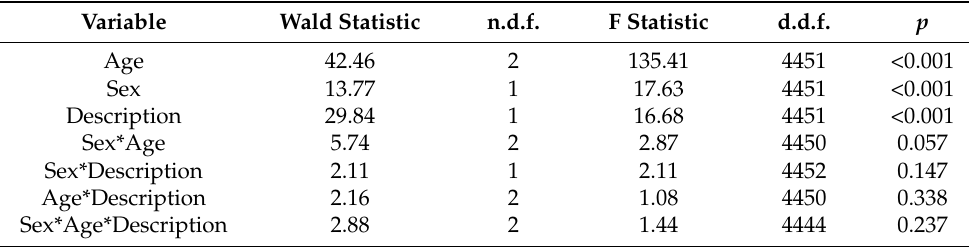
Table 5. Summary of the results from the multivariate analysis, including the analysis of potential interactions. Description = narrative voice (i.e., first person vs. third